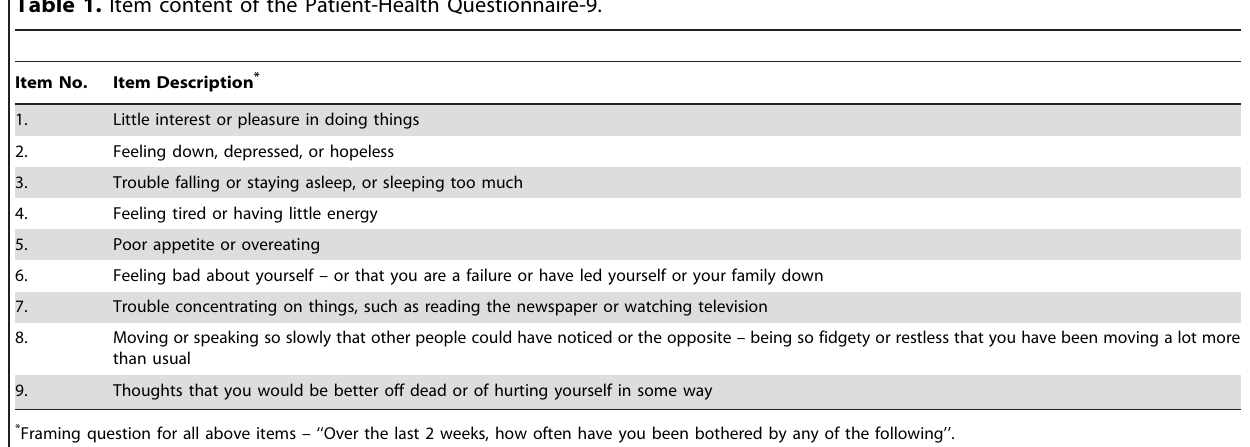
Table 1. Item content of the Patient-Health Questionnaire-9.